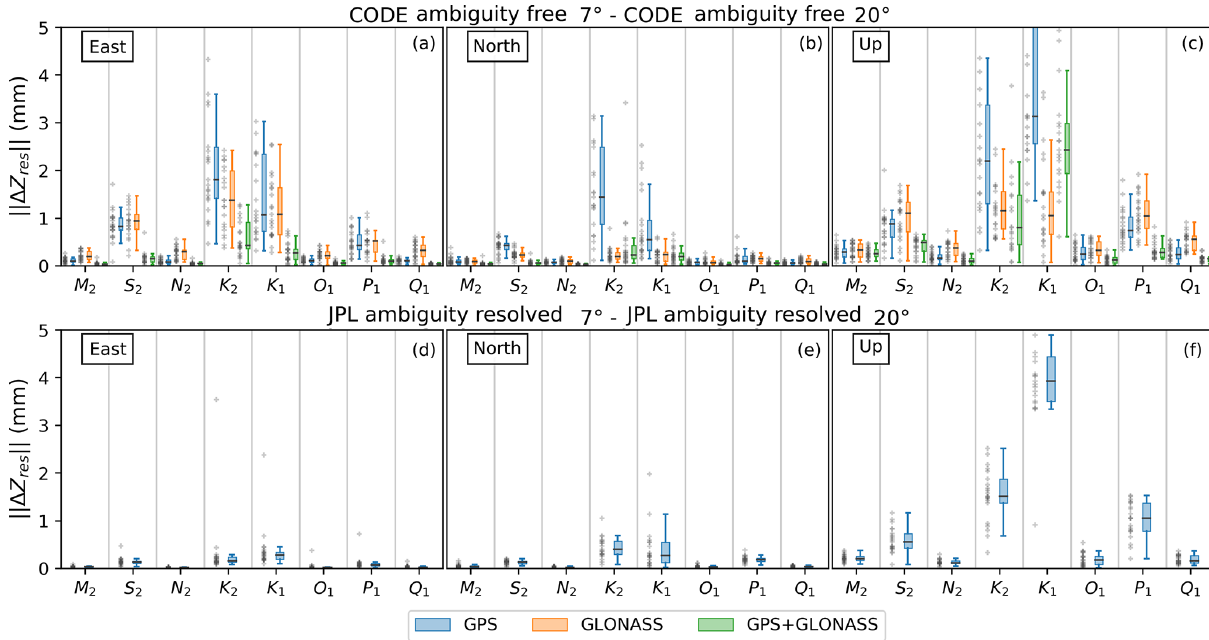
Figure 4. Magnitude of vector difference between estimated Z res values computed with 7 ◦ and 20 ◦ elevation cutoff angles, (cid:107) (cid:49)Z res (cid:107) , within the same set of orbits and clocks ( a–c CODE; d–f JPL AR) for east, north and up coordinate components (left, middle and right, respectively). Grey crosses are as per Fig. 3. The smaller residuals using CODE products with GPS+GLONASS (a–c) are a result of improved OTL stability as a function of cutoff angle using combined constellations (except K 1 up and K 2 up). JPL’s GPS AR also shows great stability, with the exception of K 2 up and K 1 up. (cid:107) (cid:49)Z res (cid:107) for GPS, GLONASS and GPS+GLONASS PPP solutions is in blue, orange and green,